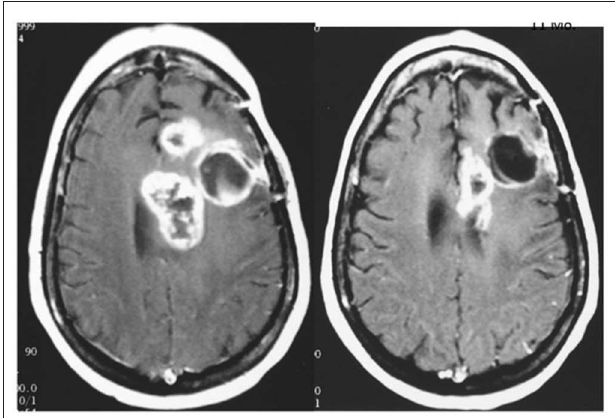
FIGURE 3 | MRI of brain of a 42 year old female with recurrent glioblastoma showing significant mass reduction with free thyroxine depletion at 4 months. Left, pre-thyroxine depletion; right, 4 months later. The patient survived for 3 years. Reprinted with permission from Hercbergs et al. (